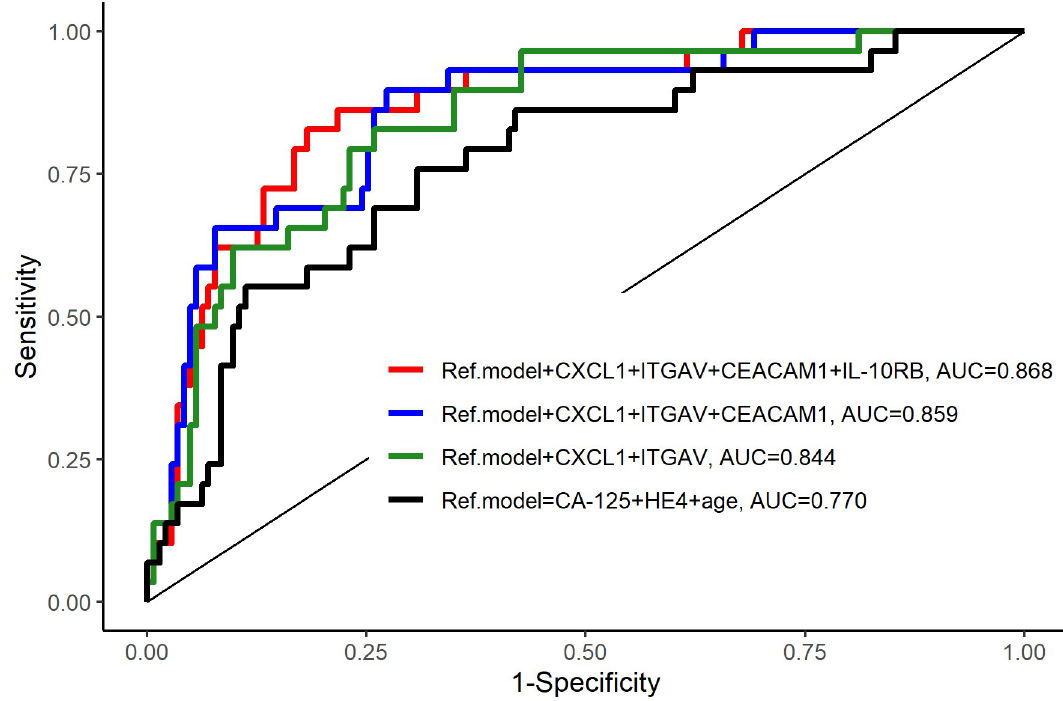
Fig 4. ROC curves for biomarker models. Benign tumors versus borderline +